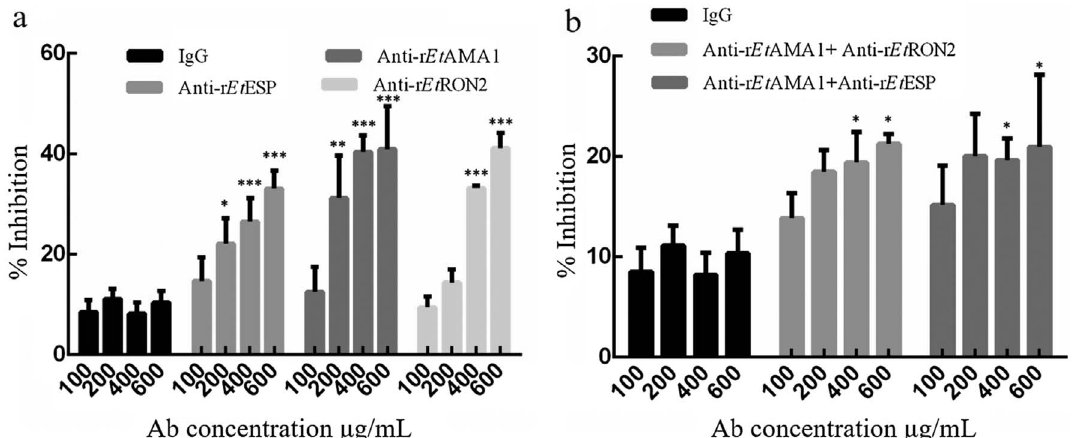
Figure 3. Inhibition of sporozoite invasion in vitro by antibodies against rEtAMA1, rEtESP, and rEtRON2. (a) Invasion-inhibition activities of single antibodies. Anti-rEtAMA1, rEtESP, and rEtRON2 rabbit anti-serum against recombinant EtAMA1, EtESP and EtRON2 protein, respectively; IgG, normal rabbit serum. (b) Invasion-inhibition activities of antibody combinations. Combinations of anti-rEtAMA1 and anti- rEtESP or anti-rEtRON2 were added at a ratio of 1:1 to generate a gradient concentration of IgG. All assays were performed in triplicate. * p < 0.05, ** p < 0.01 and *** p < 0.001, as determined by the Student ’ s t -test versus the non-immunized IgG groups at the same